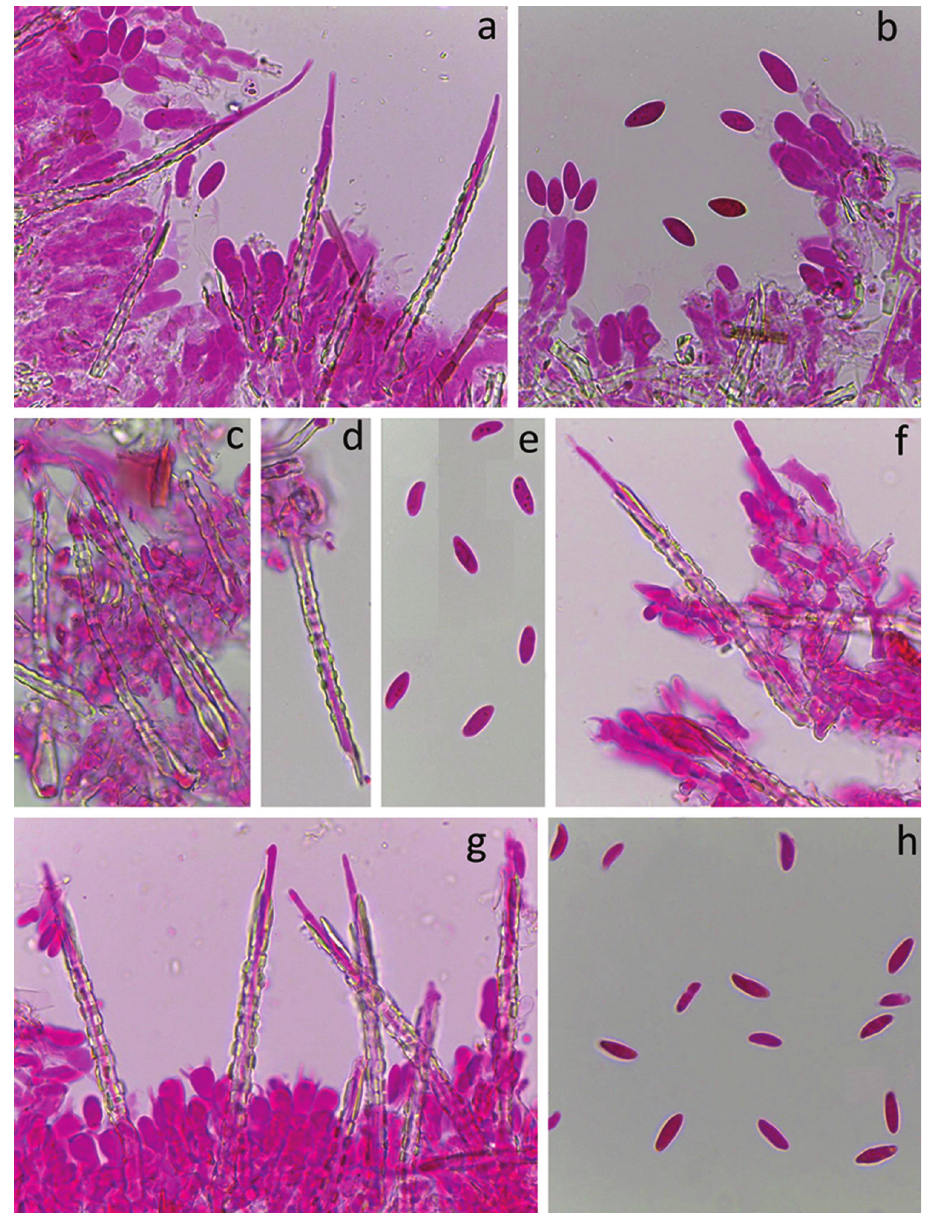
Figure 3. Species of Subulicystidium with broad fusiform basidiospores. Subulicystidium naviculatum (GB:KHL 11566): a, b hymenium and basidiospores. Subulicystidium ryvardenii (LR 8860/b in O:F 909583, holotype): c, d cystidia e basidiospores. Subulicystidium robustius (GB:KHL 10813, holotype): f, g cystidia in hymenium h basidiospores. All preparations done in 3% aqueous solution of potassium hydroxide (KOH) mixed with 1% aqueous solution of Phloxine. All scale bars equal 10